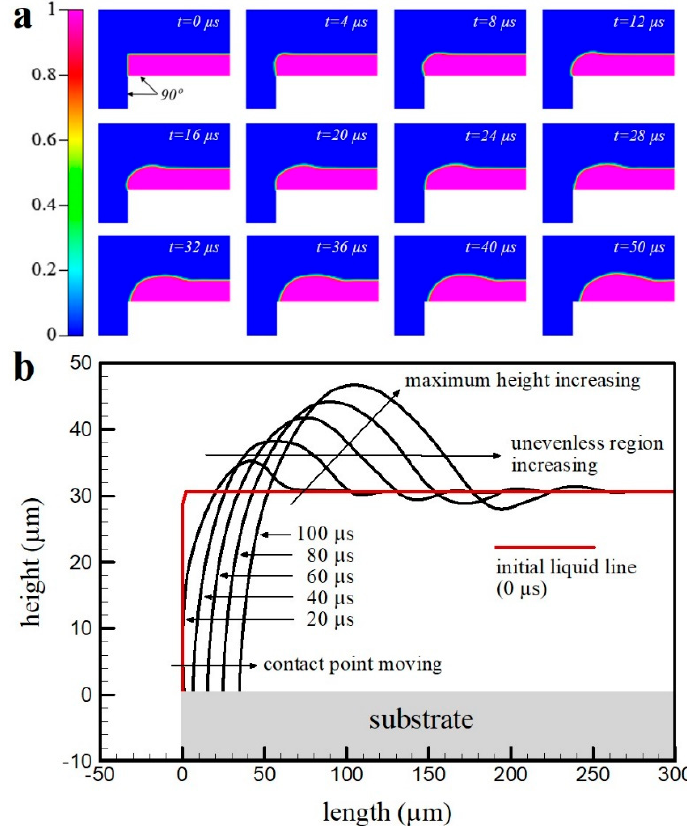
Figure 4. ( a ) Coating fluid behavior over time at the edge of the substrate under the same wetting condition of 90°. ( b ) Surface profile under the same wetting condition of 90°.